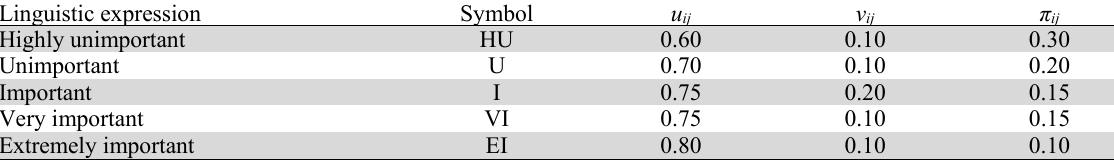
Linguistic expressions for the criteria importance evaluation Linguistic